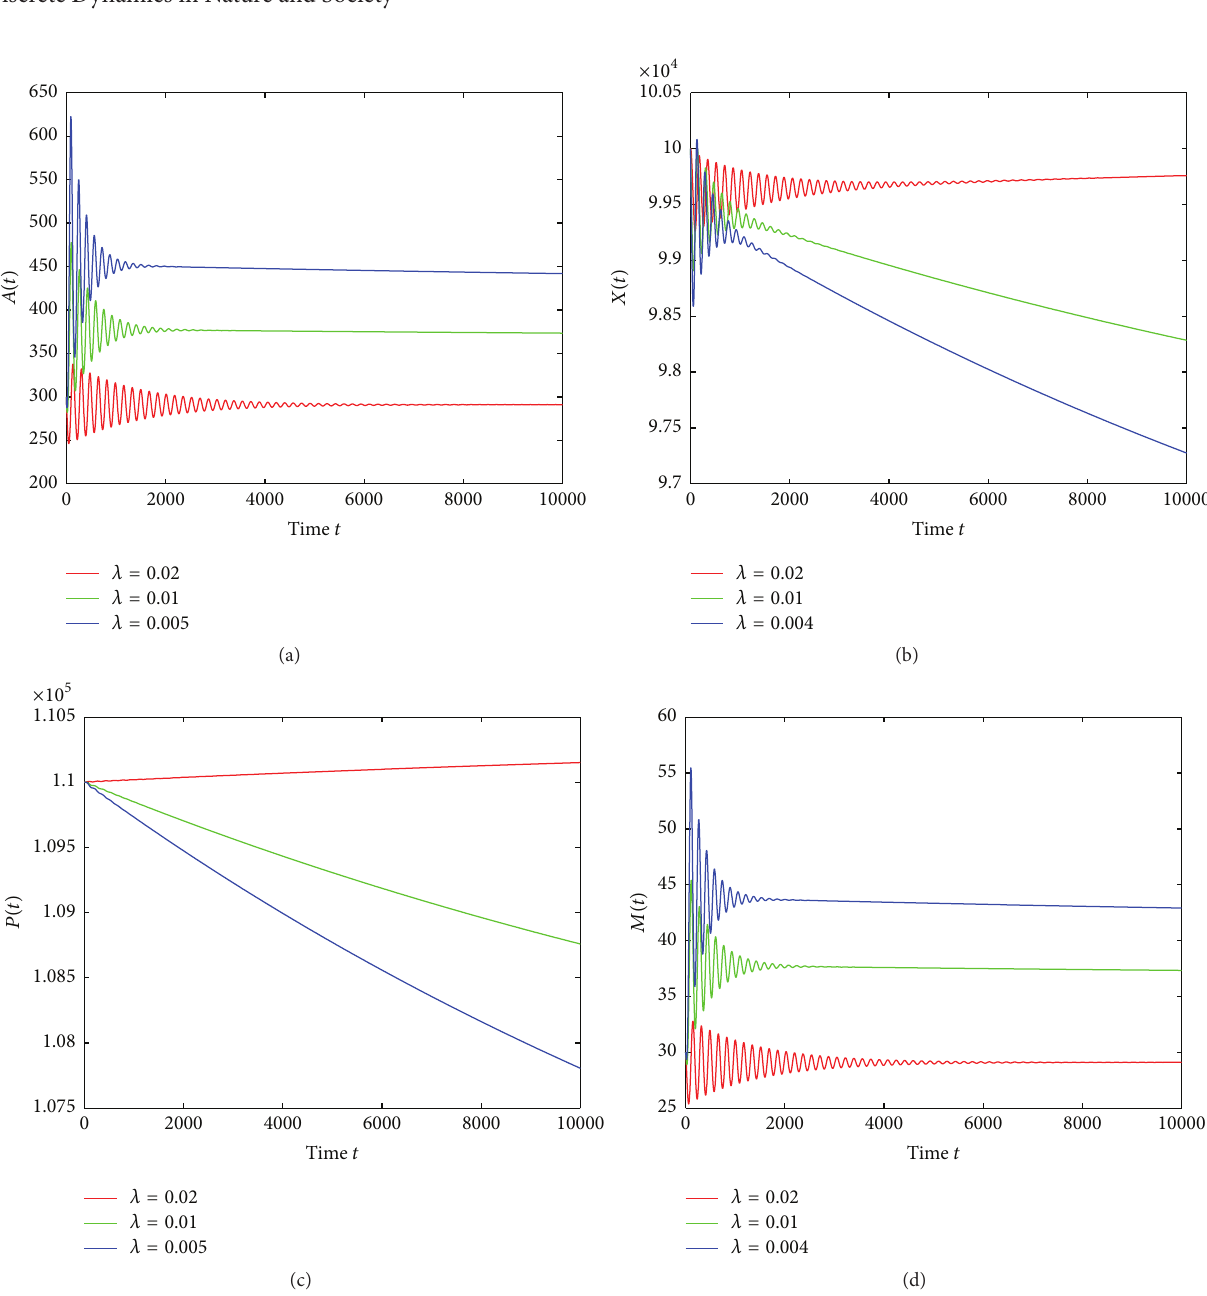
Figure 3: Trajectories of populations and awareness program changes for different values of 𝜆